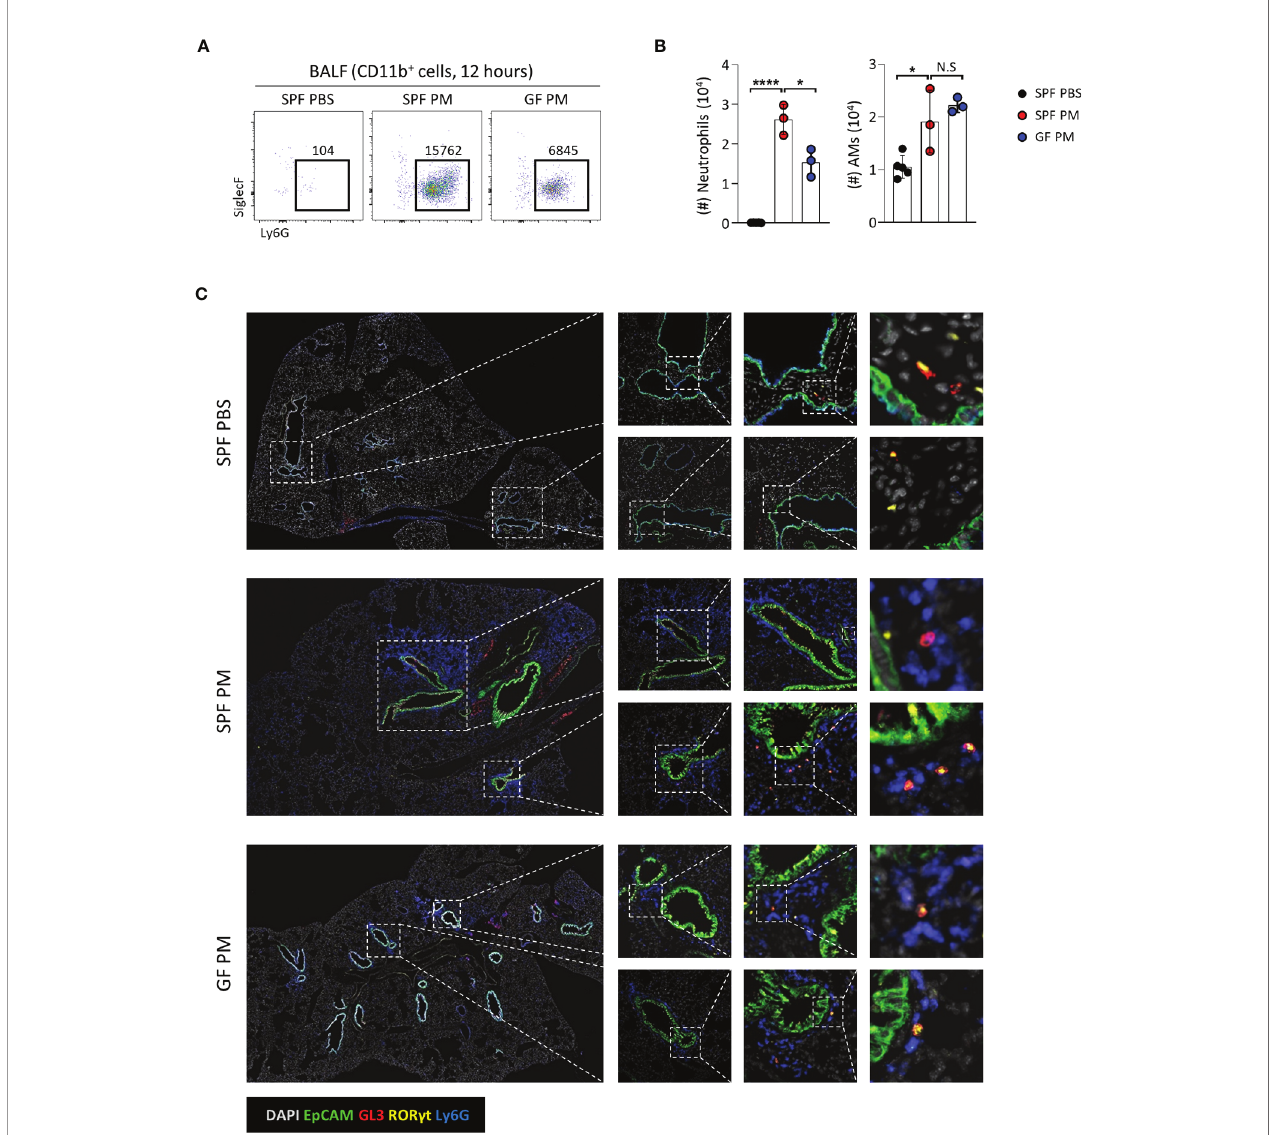
FIGURE 6 | Commensal microbiota promote PM-induced acute neutrophilic airway in fl ammation. B6 SPF and GF mice were intranasally administered with 250 m g of PM or PBS and analyzed at 12 hours after PM exposure. (A) Representative dot plots show neutrophils in broncho-alveolar lavage fl uid (BALF). Numbers indicate absolute numbers of cells in adjacent gates. (B) Graph shows statistical analysis of absolute number of neutrophils and alveolar macrophages (AMs) in BALF. (C) Representative immunohistochemical staining images of lungs from SPF PBS, SPF PM, and GF PM mouse group (N = 3 ~ 5). Each dot represents an individual mouse and horizontal bars show mean values. Data are presented as mean ± SD. Unpaired two-tailed t -test was used. N.S, not signi fi cant ; *P < 0.05, ****P < 0.0001. SPF, speci fi c pathogen free; GF, germ-free; PM, particulate matter; AMs, alveolar